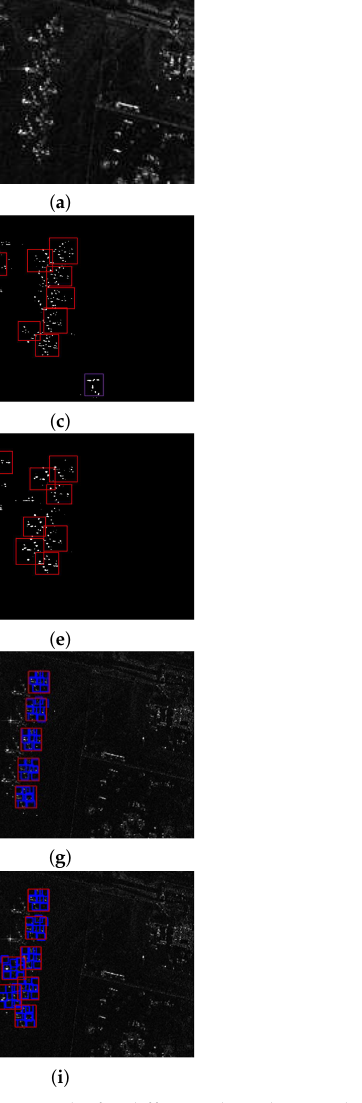
Figure 7. Target detection results for different algorithms with the Davis–Monthan AFB data set for detecting airplanes. ( a ) original image; ( b ) Gamma distribution-based CFAR; ( c ) Rayleigh distribution-based CFAR; ( d ) Log-Normal distribution-based CFAR; ( e ) Weibull distribution-based CFAR; ( f ) Gamma SDMC model; ( h ) Rayleigh SDMC model; ( h ) Log-Normal SDMC model; ( i ) Weibull SDMC model; and ( j ) MSDMC